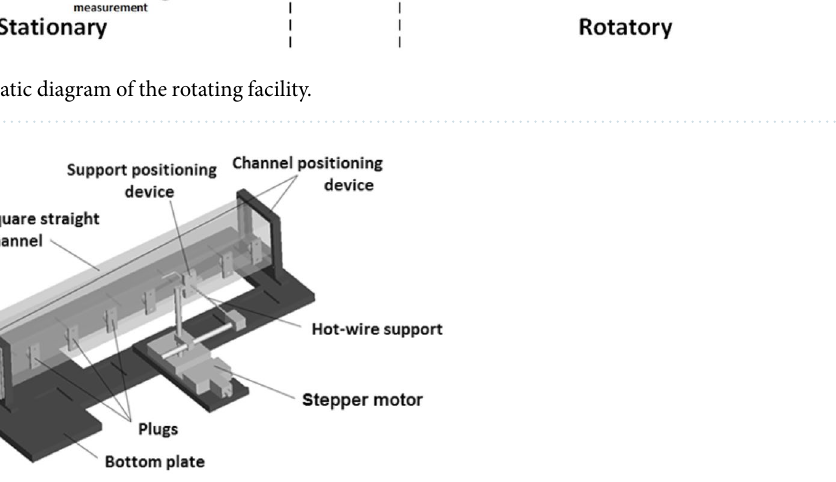
Figure 2. The square channel of the test